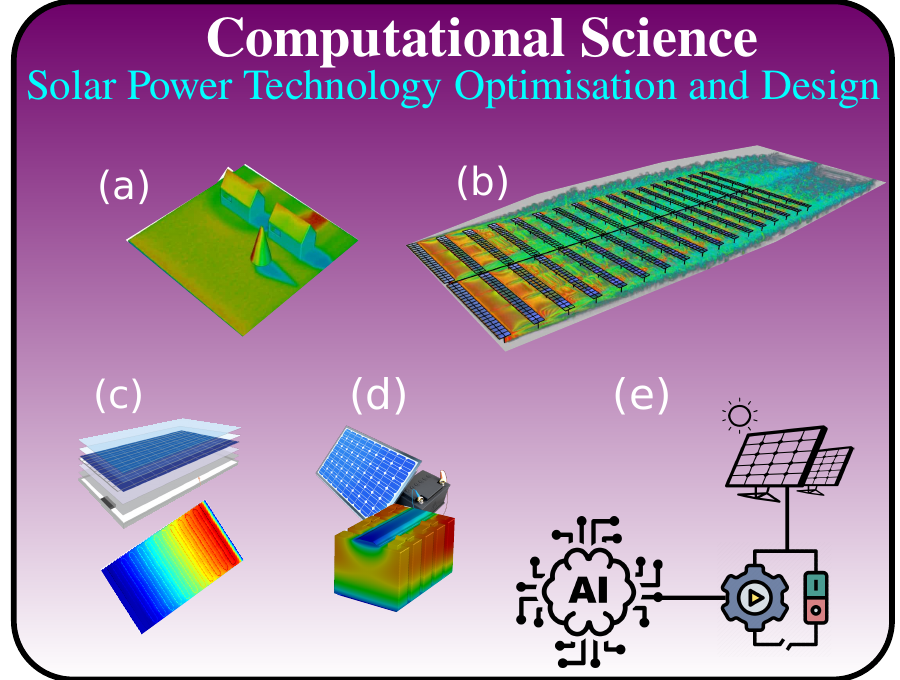
Figure 5. Computational science: Multi-disciplinary design and optimisation of solar power energy components and systems. ( a ) Solar radiation prediction; ( b ) wind load prediction in solar panels power plant; ( c ) optimal design of materials and internal components; ( d ) optimisation and design of enhanced electrical and thermal energy storage from solar power; ( e ) artificial intelligence (AI) for enhanced automatic control of solar panels orientation and maintenance